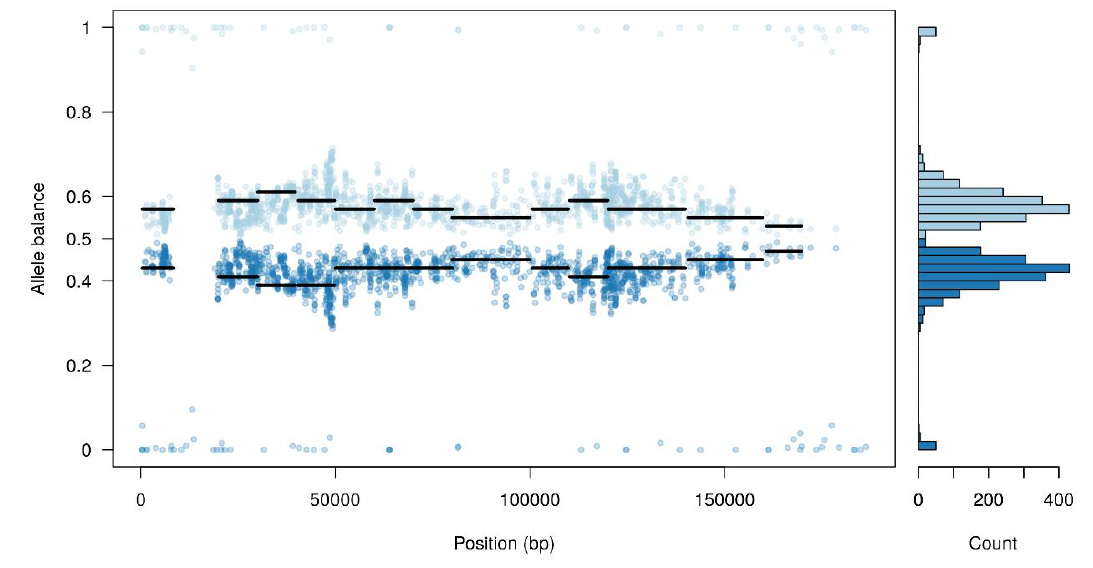
Figure 1. Allele balance distribution of variants from the Arm / 07 stock along the Georgia 2007 / 1 reference genome.